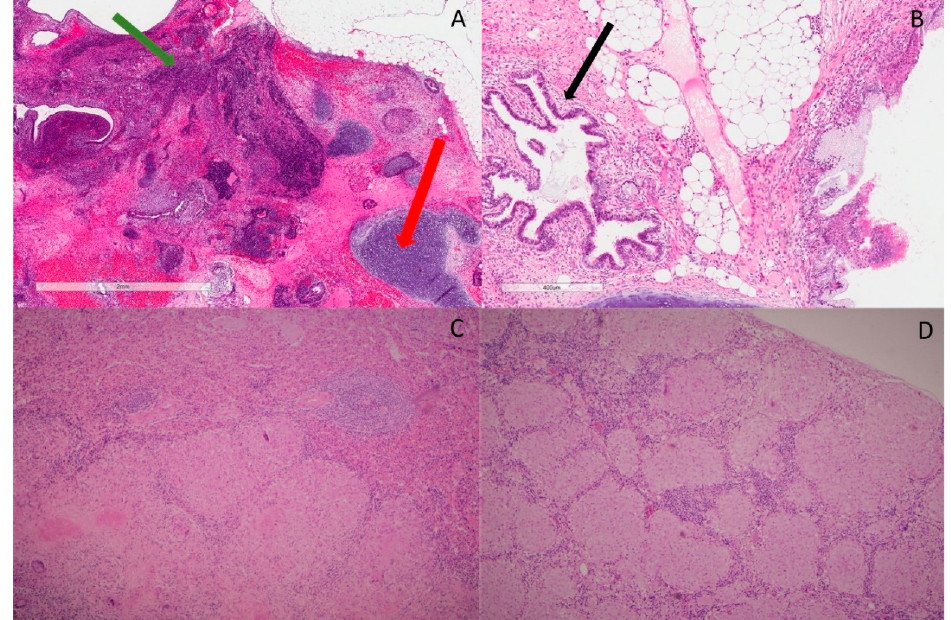
Figure 1. Histopathological features. ( A ) H&E slide × 20 magnification shows area of immature teratoma comprising primitive neuroectodermal elements (green arrow). There is surrounding cartilage, which represents part of mature teratoma (red arrow); ( B ) H&E slide × 20 magnification shows benign glands’ architecture (black arrow) with fibroblasts, fat and a small portion of cartilage in the background. No immature teratoma is identified; ( C ) H&E slide × 40 magnification shows large granulomas with epithelioid and Langerhans’s giant cells, focally with central hyalinization and necrosis in sections of spleen. Mycobacterial and fungal stains are negative; ( D ) H&E slide × 40 magnification shows well-formed, noncaseating granuloma with few surrounding lymphocytes in porta hepatis lymph